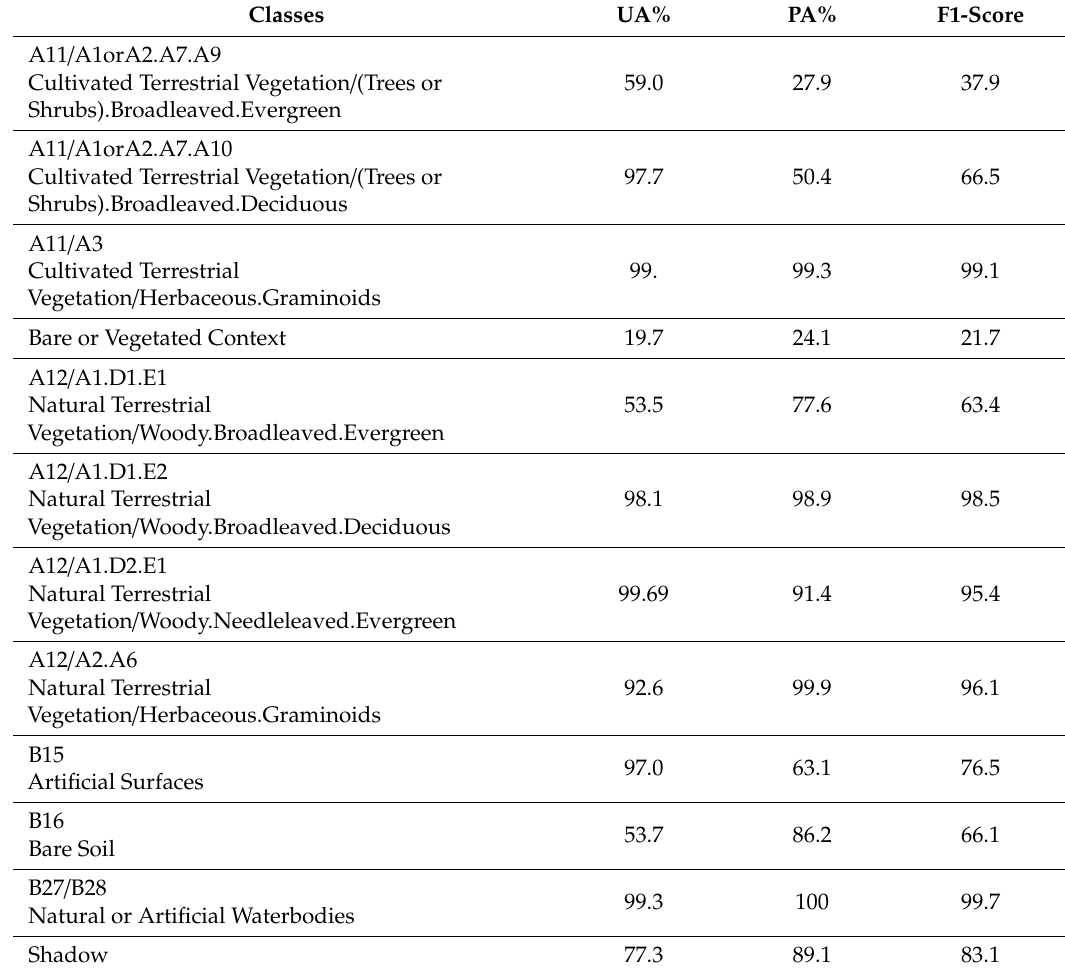
Figure 8. Confusion Matrix from the SO output map at Level 4. Rows represent SO classified pixels and columns reference pixels. Table 7. SO Accuracy assessments results at Level 4.